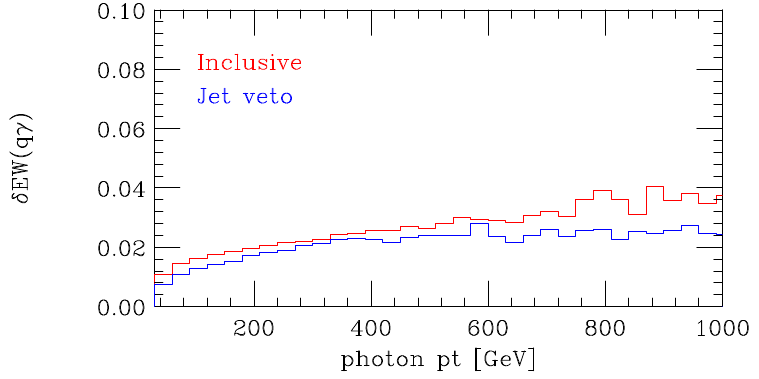
Figure 12 . Relative electroweak corrections to the O ( α s ) process in eq. (5.2), for three values of the minimum jet p . T